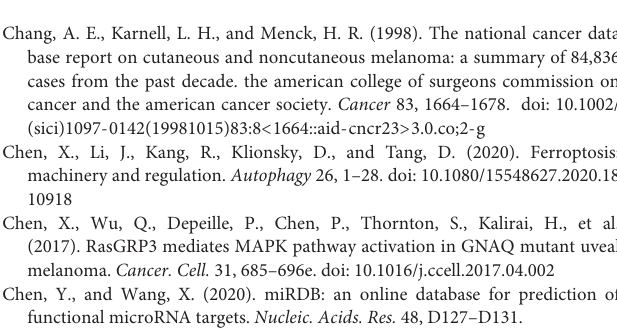
Supplementary Table 3 | Differential expression lncRNAs based on TCGA. Supplementary Table 4 | Differential expression miRNAs based on TCGA. Supplementary Table 5 | Targeted mRNAs base on miRTarBase, miRDB, and TargetScan